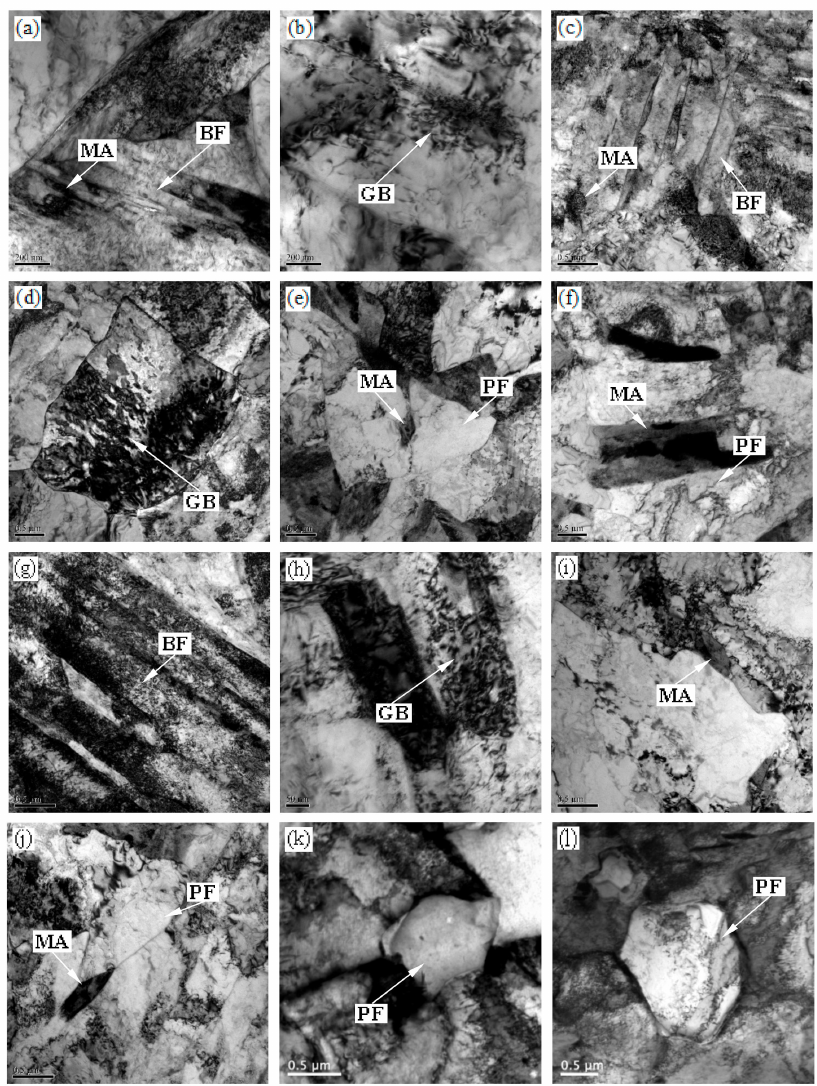
Figure 8. TEM micrographs of the specimens held at ( a , b ) 550 ◦ C; ( c , d ) 600 ◦ C; ( e , f ) 650 ◦ C; ( g , h ) 700 ◦ C; ( i , j ) 750 ◦ C; ( k , l ) 800 ◦